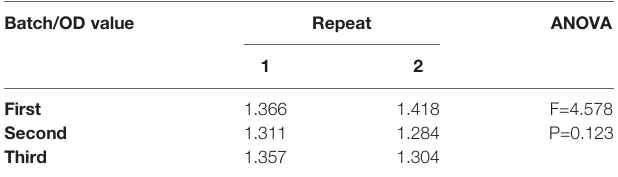
TABLE 2 | Inter-batch